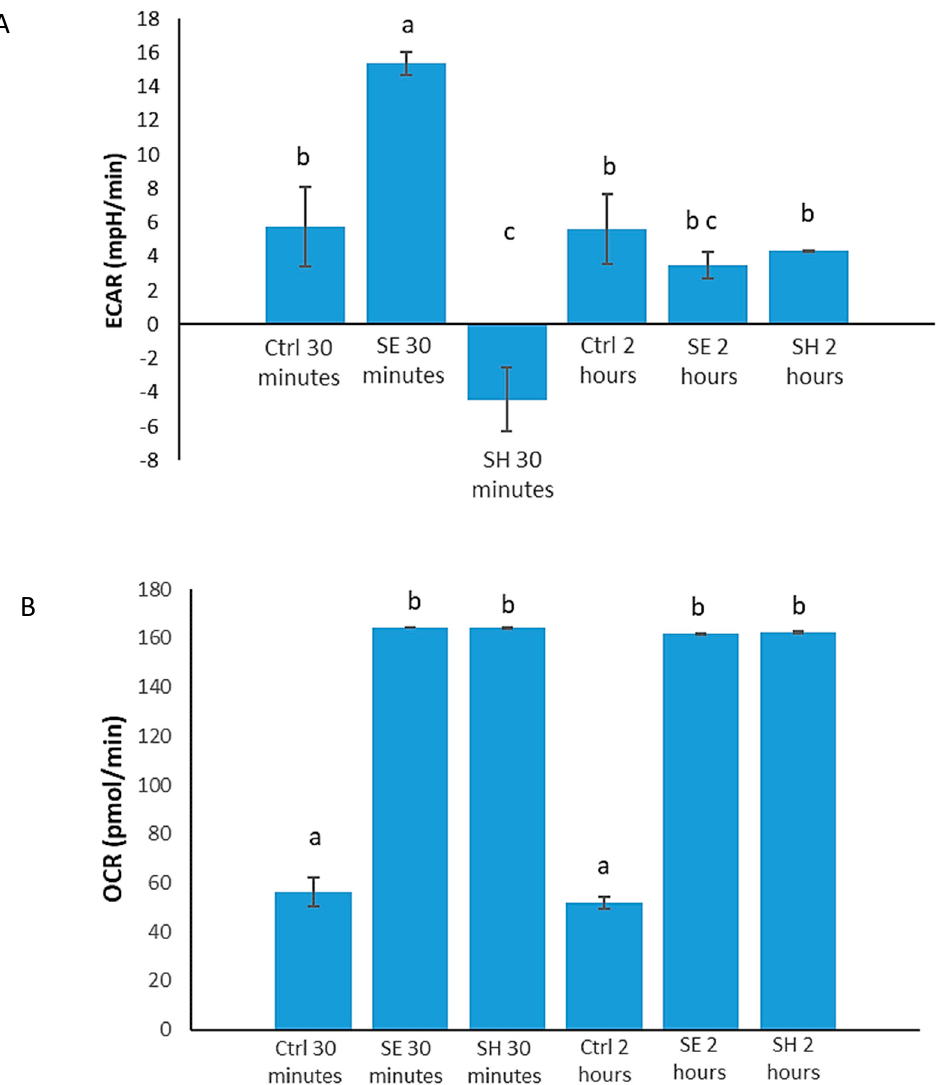
Figure 1. The metabolic differentiation induced by S. Enteritidis and S. Heidelberg during infection of chicken macrophages. ( A ) extracellular acidification rate (ECAR) readings and ( B ) and oxygen consumption rate (OCR) readings of S . Enteritidis and S . Heidelberg infected HD11 cells compared to uninfected HD11 cells. Before running the assay, the cells plated in a mini culture plate were incubated in a CO 2 -free incubator for at least 30 min upon the addition of glucose-free media. After incubation, S . Enteritidis or S . Heidelberg was added to the respective wells and the assay was started. Bars with the same letters on the top are not significantly different from each other. p ≤ 0.05 observed using Tukey–Kramer statistical tests following ANOVA. Ctrl, Control; SE, S . Enteritidis; SH, S .